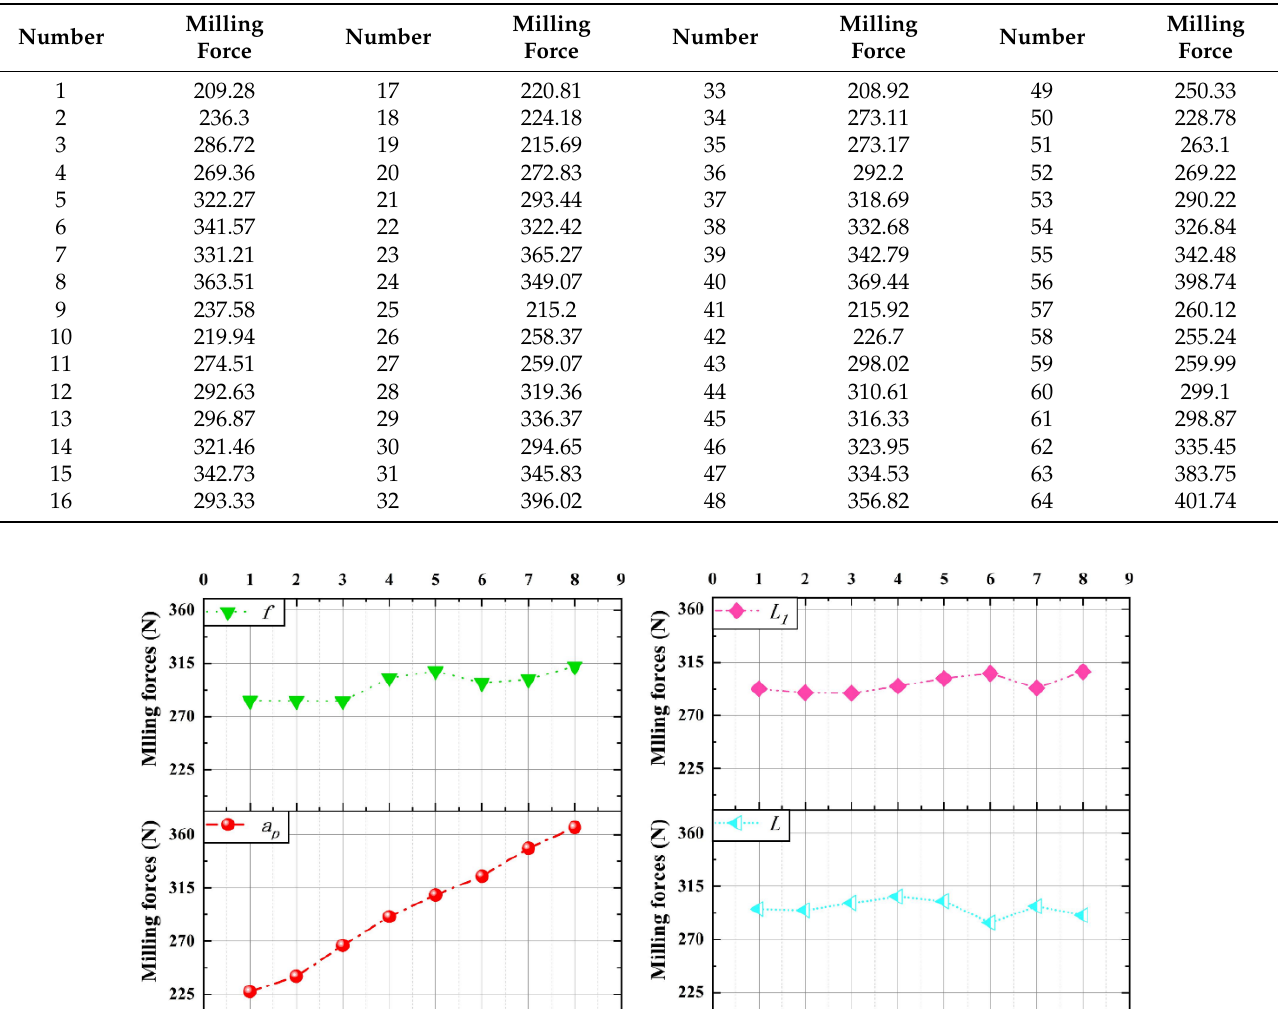
Table 2. Experimental results of milling force (N).